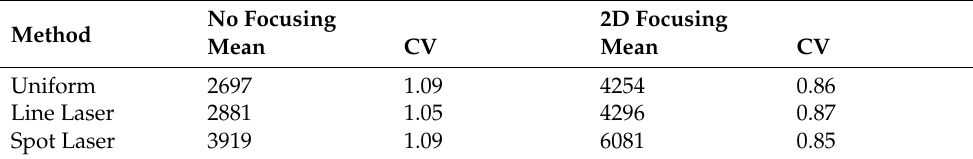
Table 6. Comparison of mean and CV for different illumination methods.